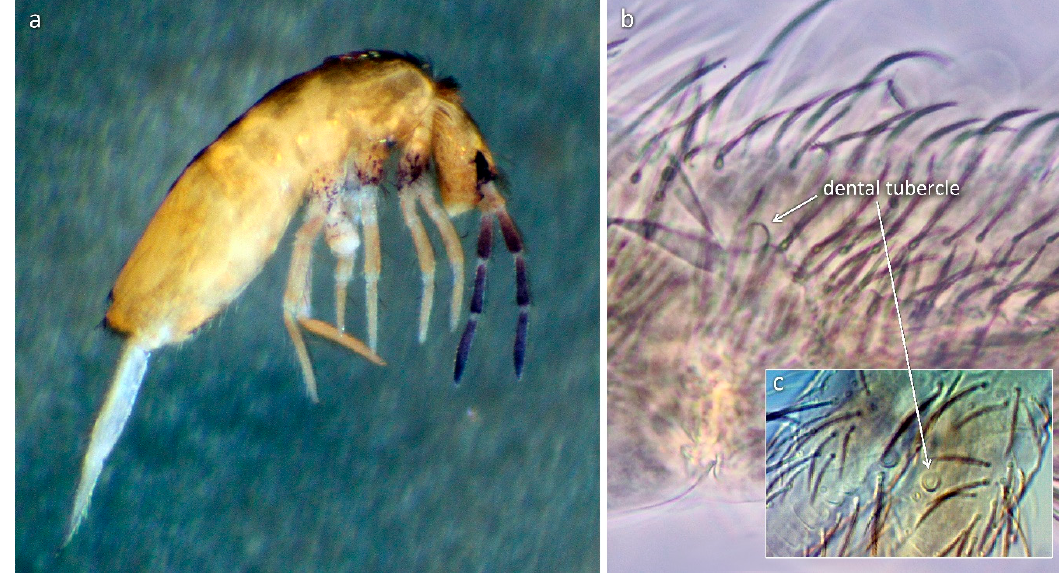
Figure 2. Lepidocyrtus tomosvaryi : ( a ) Habitus; basal part of dens with rounded dental tubercle in ( b ) lateral and ( c ) dorsal view.